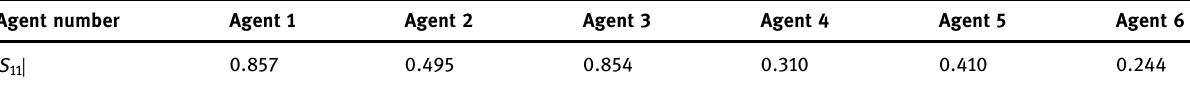
Table 2: When each microwave source agent is heated individually | | S 11 Agent number